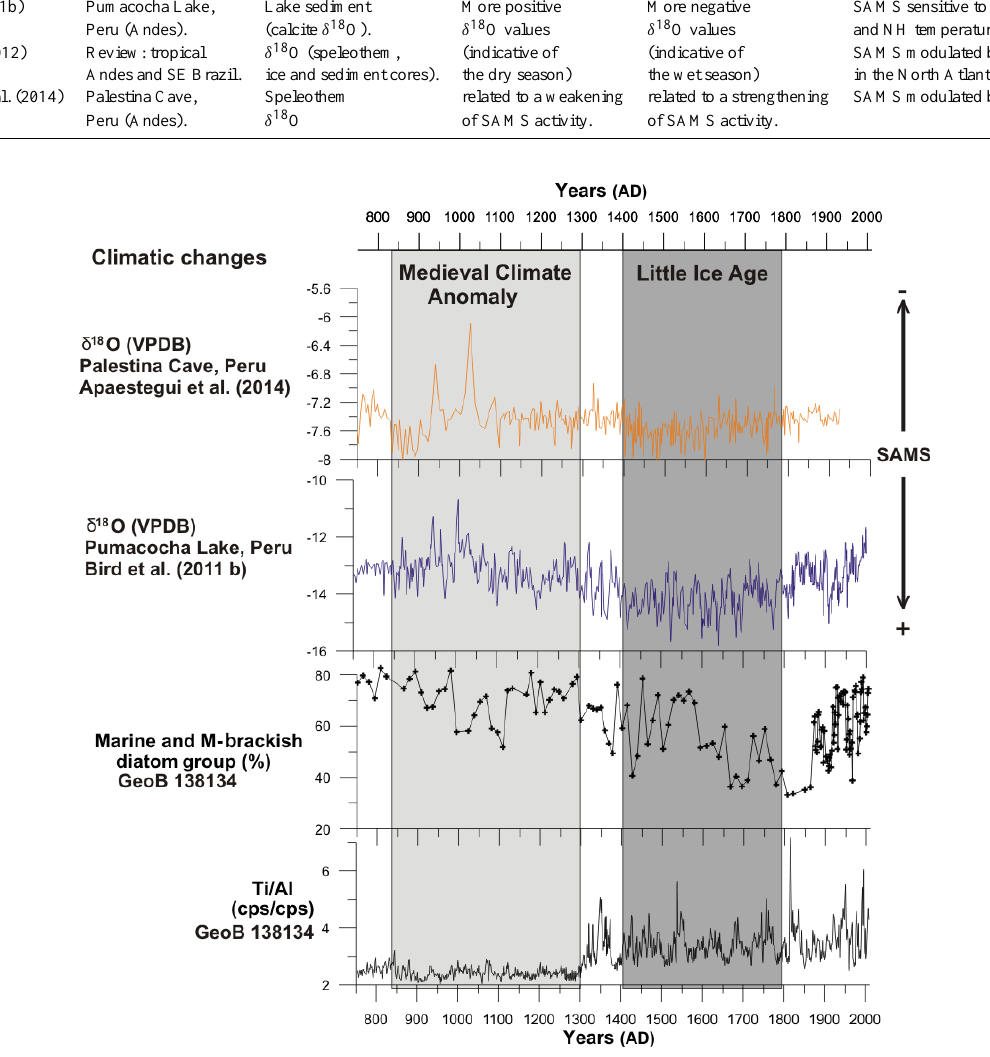
Figure 4. From top to bottom: Palestina Cave and Pumacocha Lake δ 18 O records of SAMS intensity (Apaéstegui et al., 2014; Bird et al., 2011b), the marine/marine-brackish salinity-indicative diatom group and Ti / Al ratios from the sediment core GeoB 13813-4 during the last 1200yrBP (750–2000calyrAD). Note that the lowest δ 18 O values (Apaéstegui et al., 2014; Bird et al., 2011b) are associated with higher rainfall and stronger SAMS activity, which correspond to higher Ti / Al and lower relative abundance of marine